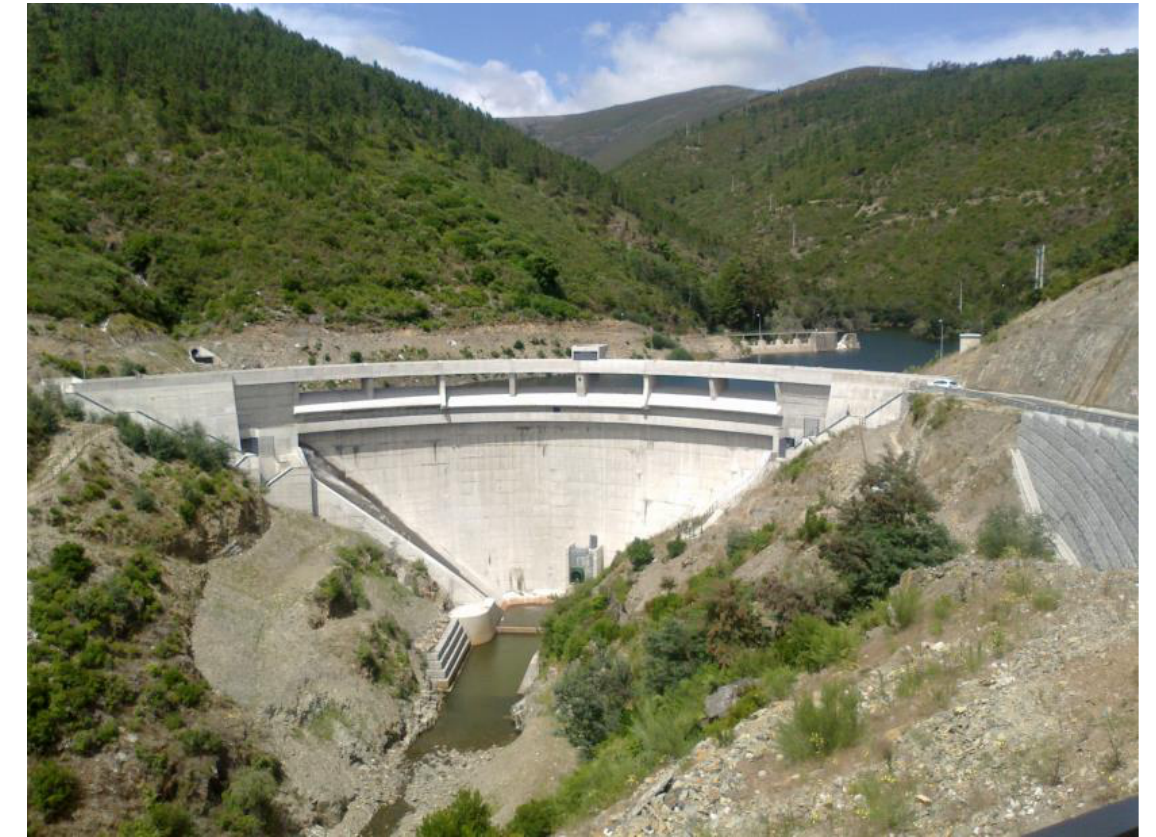
Figure 3. Downstream view of Alto Ceira II dam.